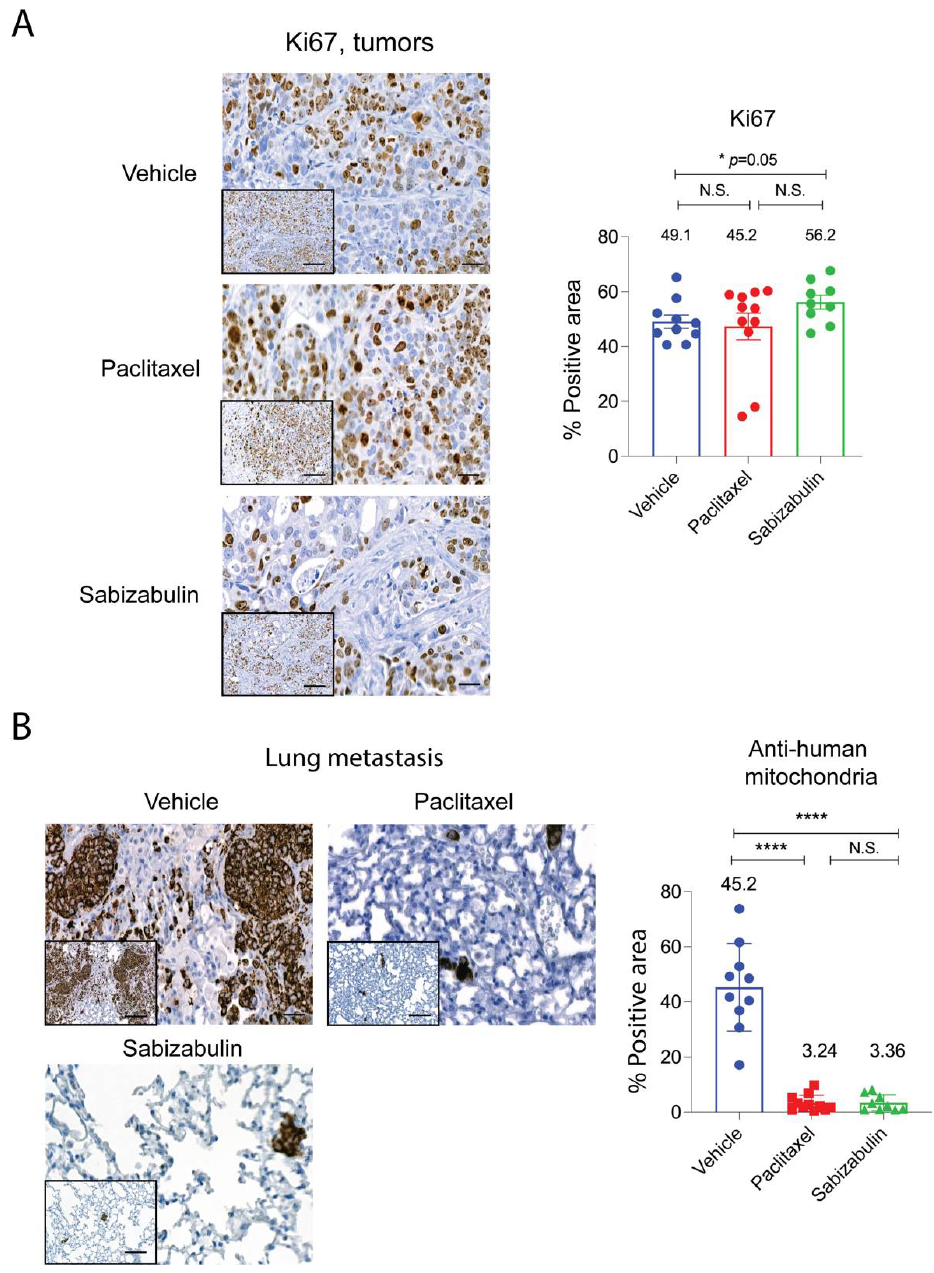
Figure 6. Sabizabulin treatment suppresses lung metastasis as effectively as paclitaxel. Representative images and quantification of signal for Ki67 immunostained tumors ( A ) and lungs stained with an anti-human specific mitochondrial marker to detect metastases ( B ). Images were captured at either low power (200 × , inserts; scale bar 50 µ M) or higher power magnification (400 × ; scale bar 20 µ M). Areas positive for Ki67 or anti-human mitochondrial staining were quantified after scanning whole tumors (vehicle, n = 10 tumors; paclitaxel, n = 11 tumors; sabizabulin, n = 8 tumors) or whole lungs from each animal (n = 10 vehicle, n = 9 paclitaxel and n = 9 sabizabulin), and the staining intensity analyzed by pixel counts using built-in densitometry software algorithms optimized for nuclear (such as Ki67) localization or cytoplasm localization (such as anti-mitochondria) (3D Histech, Ltd. software, Budapest, Hungary). The percent (%) positive area reflects the number of positive tumor epithelial cells (Ki67) or the % area of metastatic burden (detected by anti-human mitochondria) for whole lungs. All p -values are shown relative to the vehicle control group, the mean is indicated above each group; **** p < 0.0001; N.S. is not